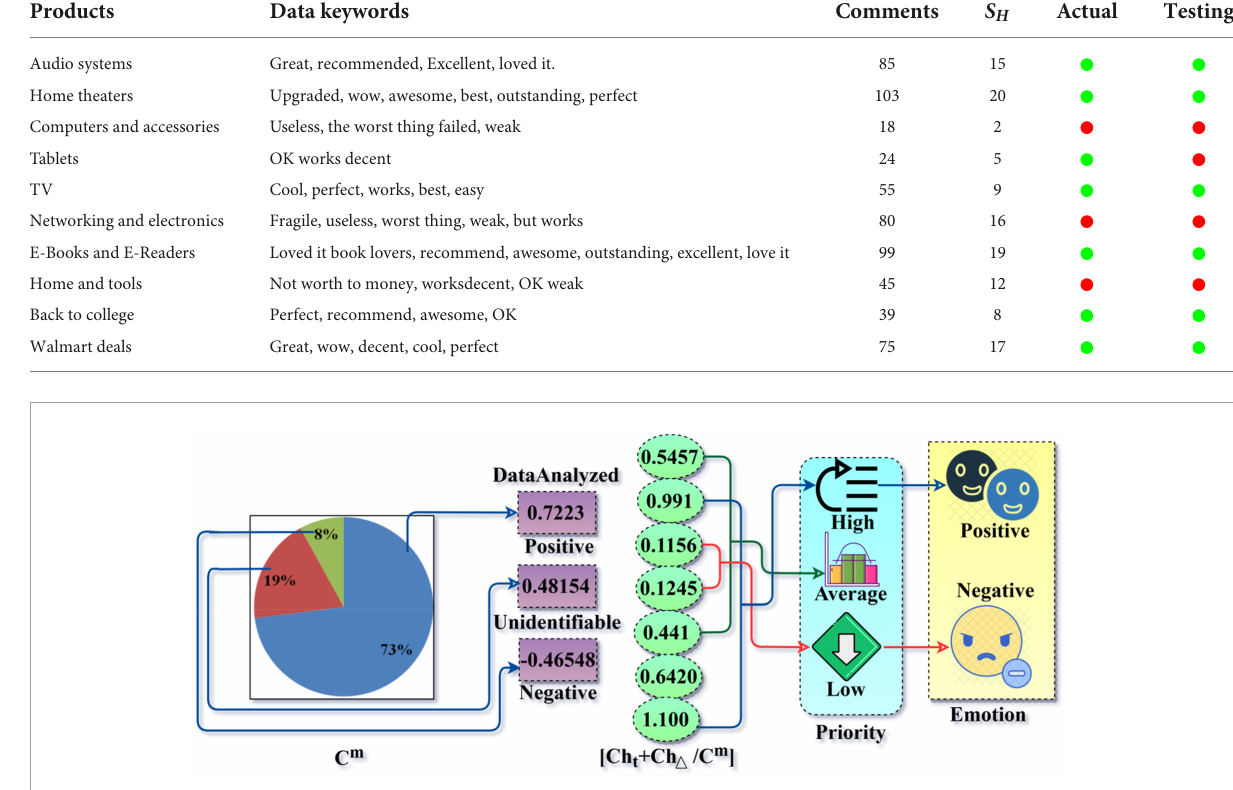
FIGURE5 R state (emotion) identification from the SDIS output.